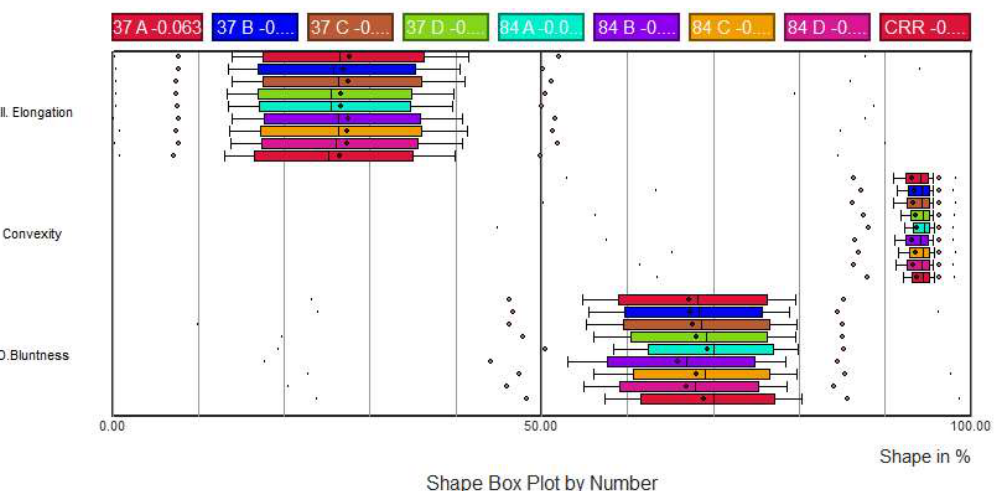
Figure A6. Shape analysis of particles (0.020–0.063 mm).